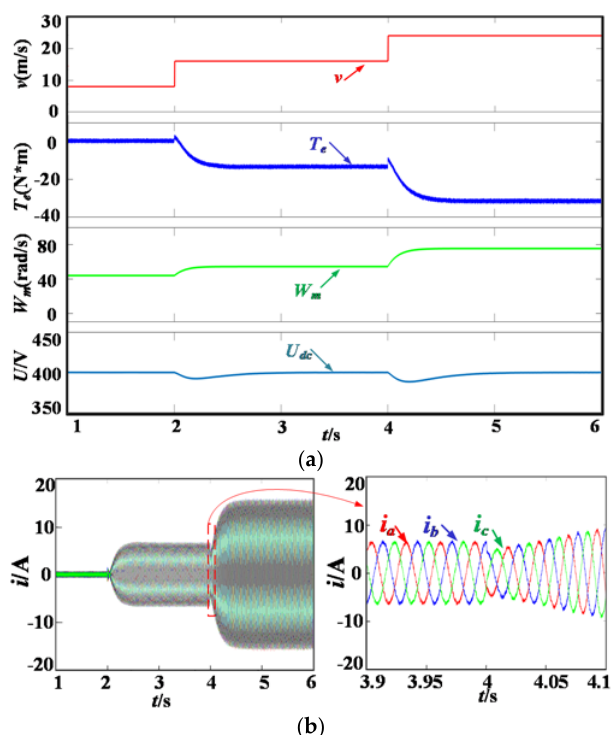
Figure 6. Wind ‐ speed influence on generator ‐ side and grid ‐ side parameters. ( a ) Wind speed, torque, Figure 6. Wind-speed influence on generator-side and grid-side parameters. ( a ) Wind speed, torque, turbine speed and DC ‐ link voltage; ( b ) Generator ‐ side three ‐ phase current, current local turbine speed and DC-link voltage; ( b ) Generator-side three-phase current, current local magnification.